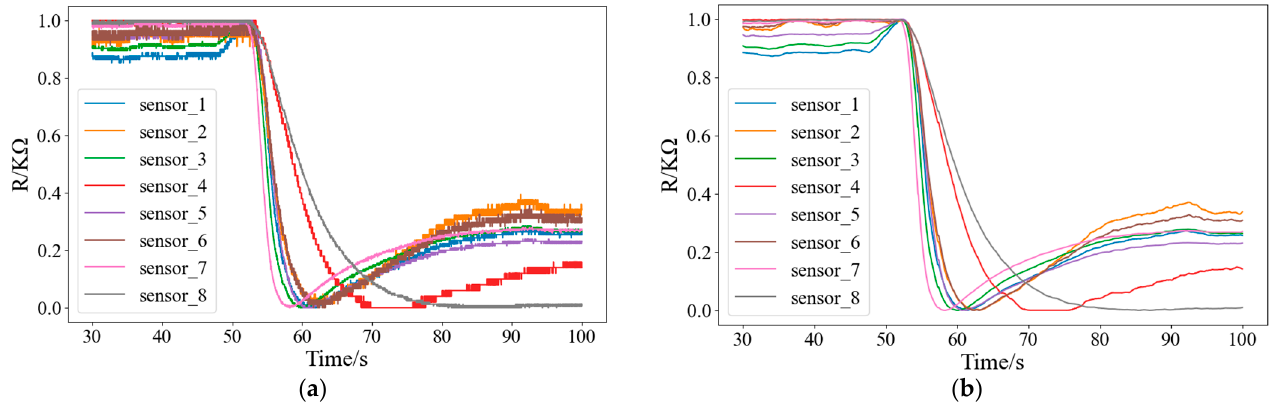
Figure 5. Gas response data curves: ( a ) without filtering after data normalization; and ( b ) with filtering after data normalization.